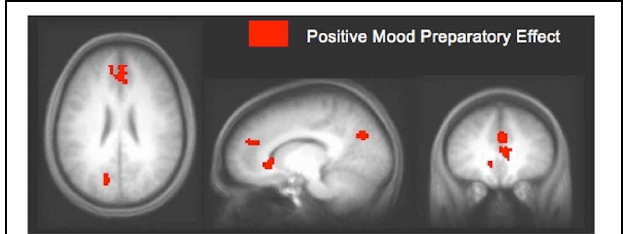
FIGURE 3 | Positive mood preparatory effect. Signal change in mPFC/ACC and posterior cingulate cortex during the preparation period for participants high in positive mood vs. participants low in positive mood, at a threshold of p < 0 . 005 (uncorrected). Increased mPFC signal enhanced cognitive preparation, predisposing positive mood participants to solve more problems overall, and to specifically solve more creatively with insight [adapted from Subramaniam et al.